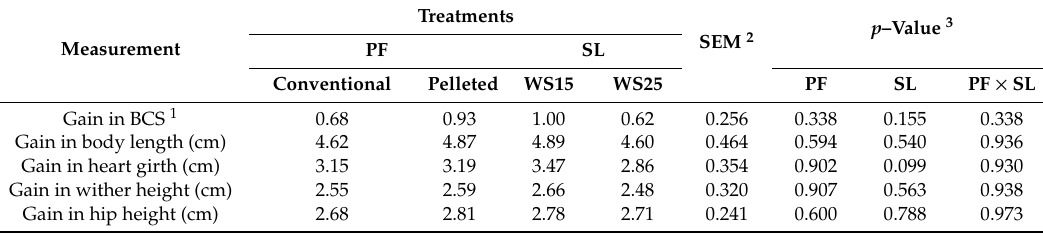
Table 4. Body condition score (BCS) and structural measurements in fattening goats fed conventional and pelleted total mixed